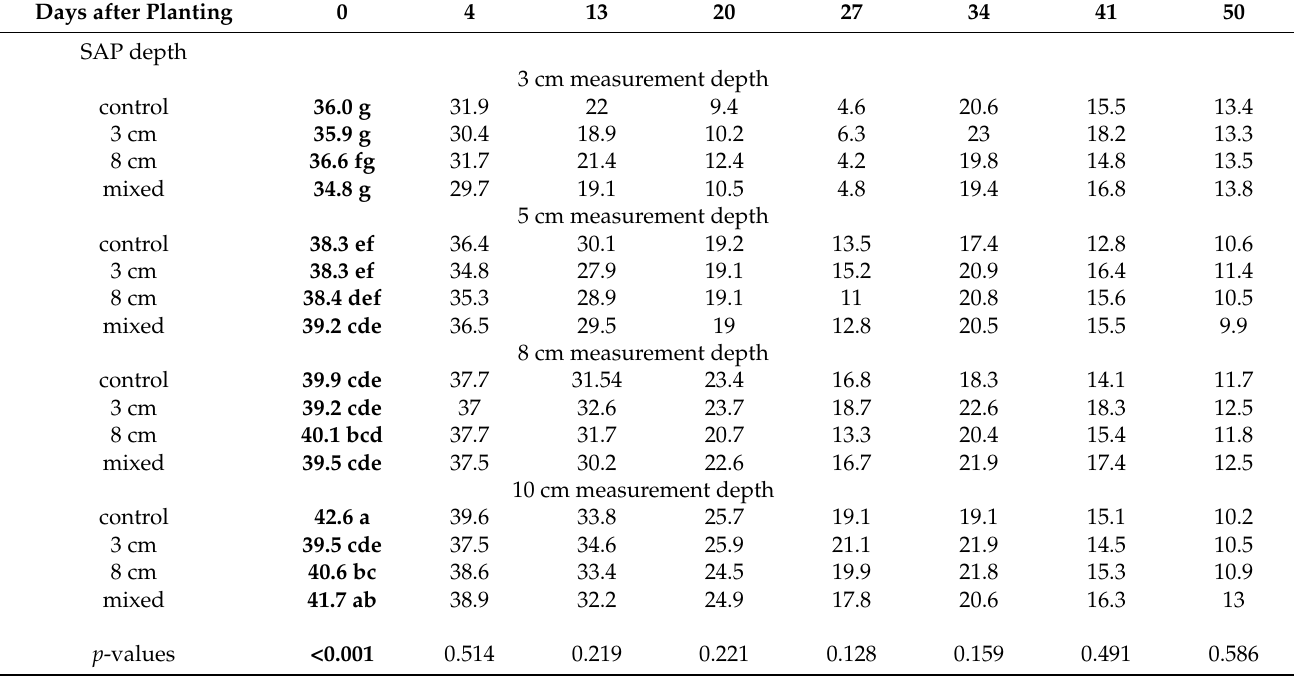
Table A3. Soil moisture with associated p -values for individual dates × superabsorbent poly- mer (SAP) placement depth × measurement depth. Values within a grouping that are significant ( p -value < 0.05) are in bold-face type and have means separated for statistical significance. Values not sharing the same letter(s) are statistically different from one